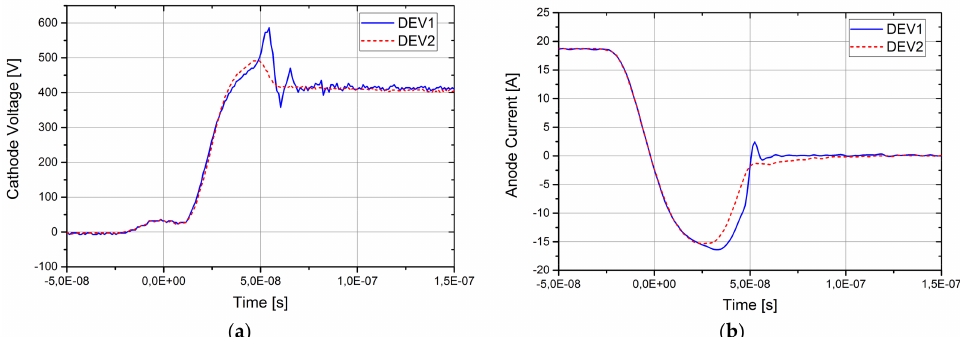
Figure 15. Comparison between the experimental DEV1 and DEV2 design reverse recovery waveforms. I A = 20 A, di/dt = 1000 A/ µ s, V K = 400 V and T = 25 ◦ C. ( a ) Voltage drop; and ( b )